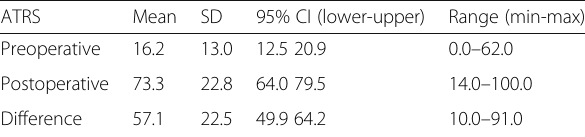
Table 4 Mean retrospective preoperative and postoperative ATRS among patients with chronic Achilles tendon ruptures. The mean difference between the two variables is also